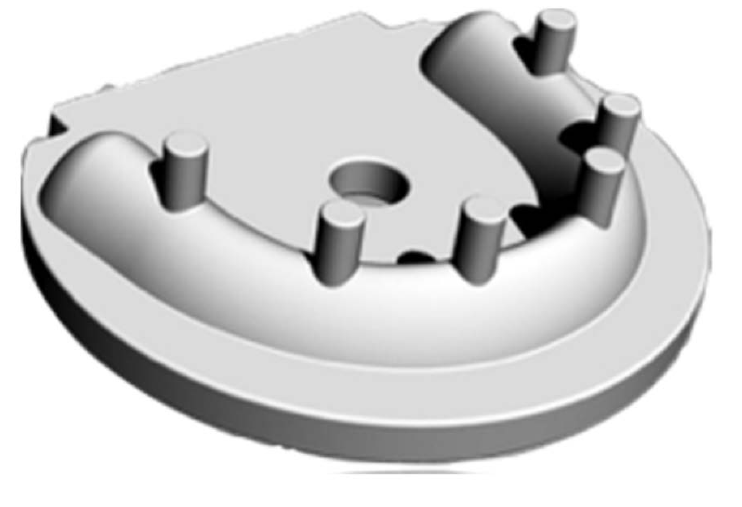
Figure 1. The design of the master model in a digital environment. The geometry of all scan bodies was a cylinder with a diameter of 4 mm. All the central axes were parallel to each other. The favorable design was chosen to easily and accurately perform the calibration measurements using a coordinate measuring machine